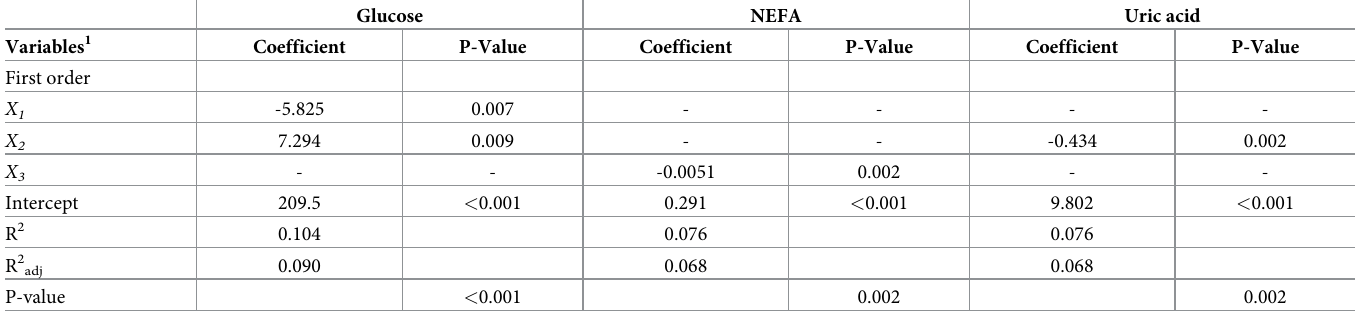
Table 11. ANOVA, coefficient estimates and summary statistics of blood parameters in response to digestible lysine concentration (SID Lys), energy density (AMEn) and starch to lipid ratios (S:L) in broiler chickens at 35 days post-hatch.